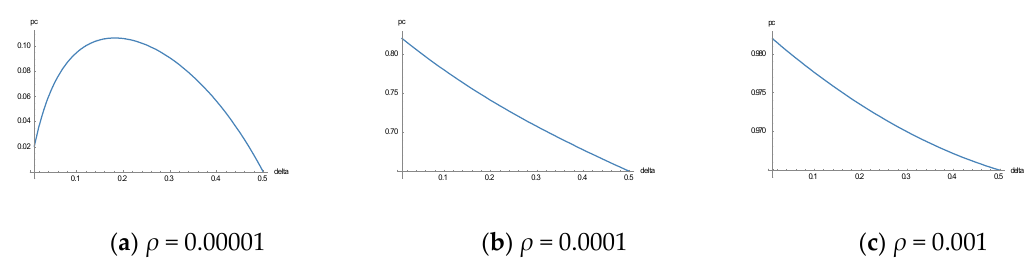
Figure 2. Tax compliance probability, p c , as a function of the trembling hand parameter, δ , for different values of ρ : ( a ) ρ = 0.00001, ( b ) ρ = 0.0001 and ( c ) ρ = 0.001 .